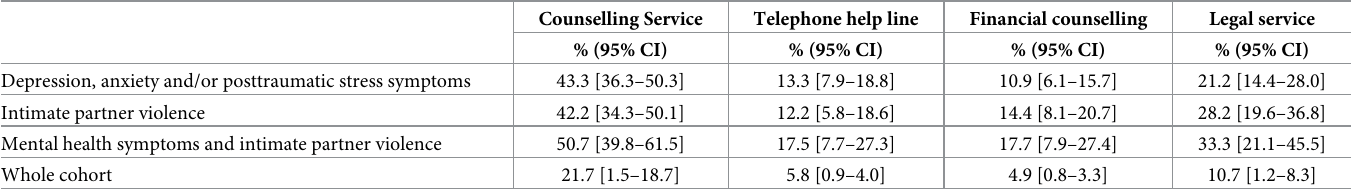
Table 5. Proportion of women experiencing mental health symptoms and recent IPV who used services in the 12 months prior to 10-year follow-up (n =